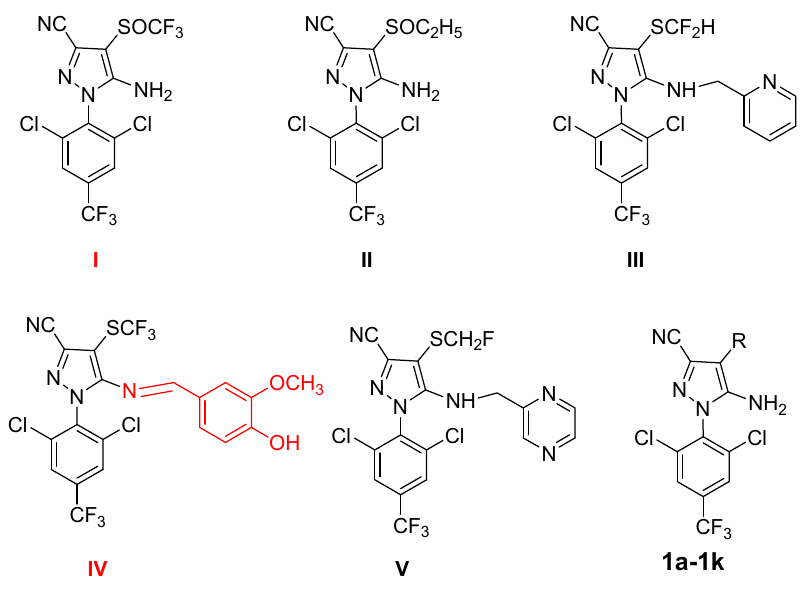
Figure 1. Chemical structure of fipronil ( I ), ethiprole ( II ), pyriprole ( III ), vaniliprole ( IV ), pyrafluprole ( V ), and derivatives of fipronil ( 1a – 1k ).